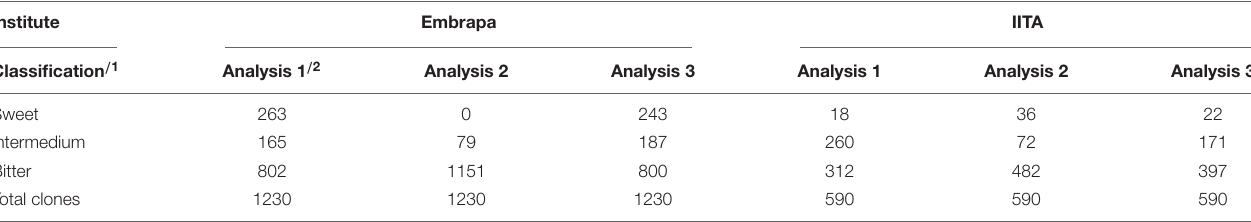
TABLE 6 | The number of cassava clones allocated in each class of HCN content, for Embrapa and IITA, according to the GEBVs estimated with marker effects from the three referred analyses. Institute Embrapa IITA Classification /